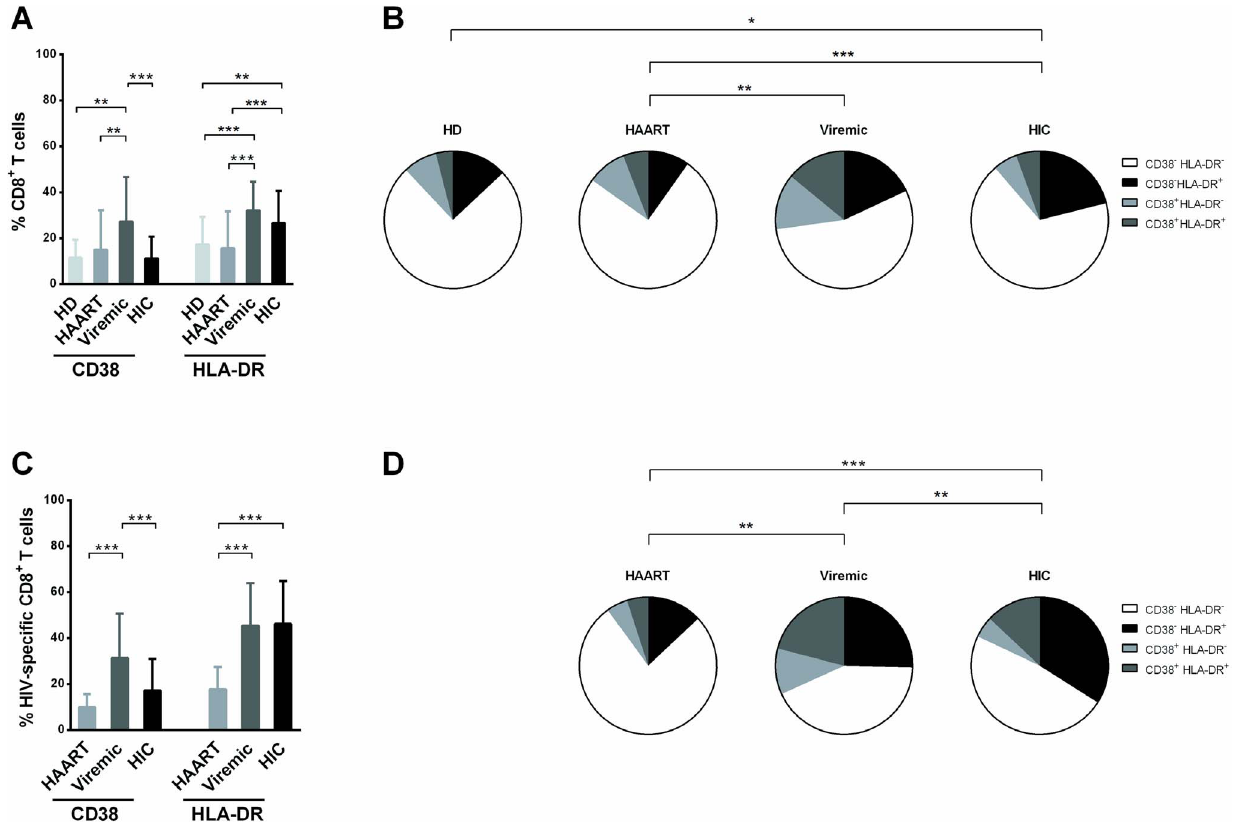
Figure 1. CD38 and HLA-DR expression on bulk and HIV-specific CD8 + T cells. (A) Proportions of bulk CD8 + T cells from HD (n=16, light gray bars), HAART-treated patients (n=19, mid gray bars), viremic patients (n=21, dark gray bars) and HIC (n=79, black bars) expressing CD38 and HLA-DR. (C) Proportions of HIV-specific CD8 + T cells from HAART-treated patients (n=13, mid gray bars), viremic patients (n=39, dark gray bars) and HIC (n=80, black bars) expressing CD38 and HLA-DR. Pie charts representing CD38 2 /HLA-DR 2 (white), CD38 2 /HLA-DR + (black), CD38 + /HLA-DR 2 (light gray) and CD38 + /HLA-DR + (dark gray) cells among bulk (B) and HIV-specific CD8 + T cells (D). Statistical differences shown in the pie charts are based on the difference in the frequency of the CD38 2 /HLA-DR + subset between the different groups. * P , 0.05, ** P , 0.01, *** P , 0.001.